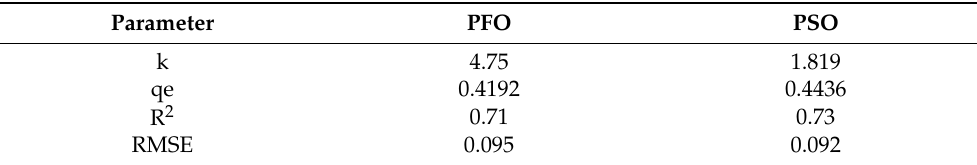
Figure 8. Adsorption kinetics data and modelling for P adsorption on the Mg-biochar. Table 6. Kinetics models fitting parameters. Table 6. Kinetics models fitting